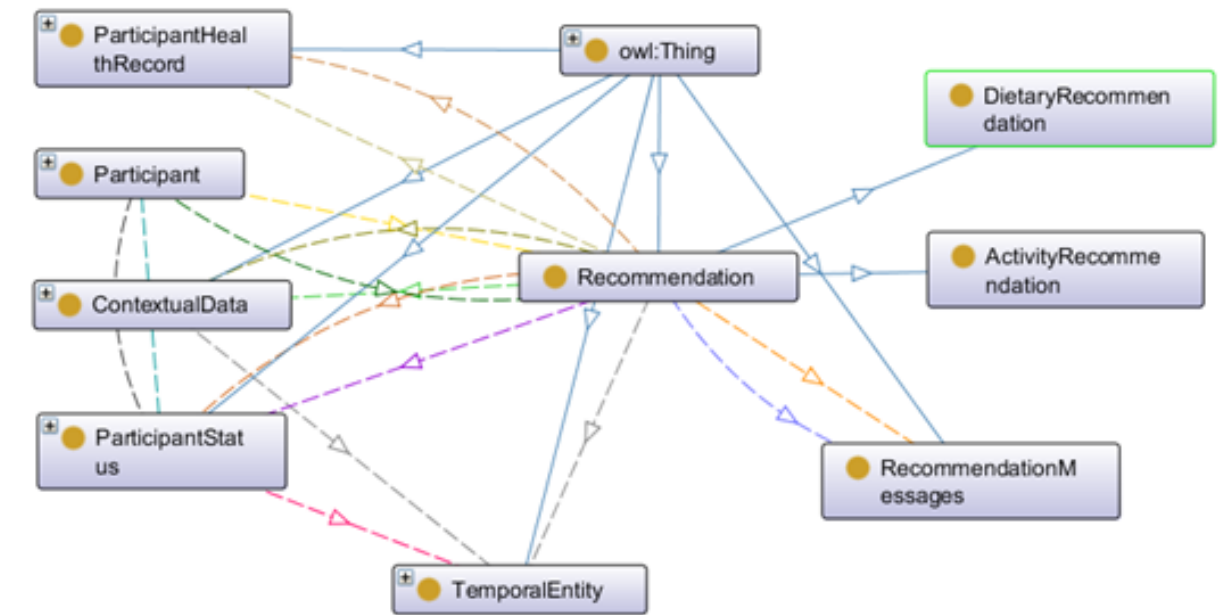
Figure 16. Ontology for recommendation